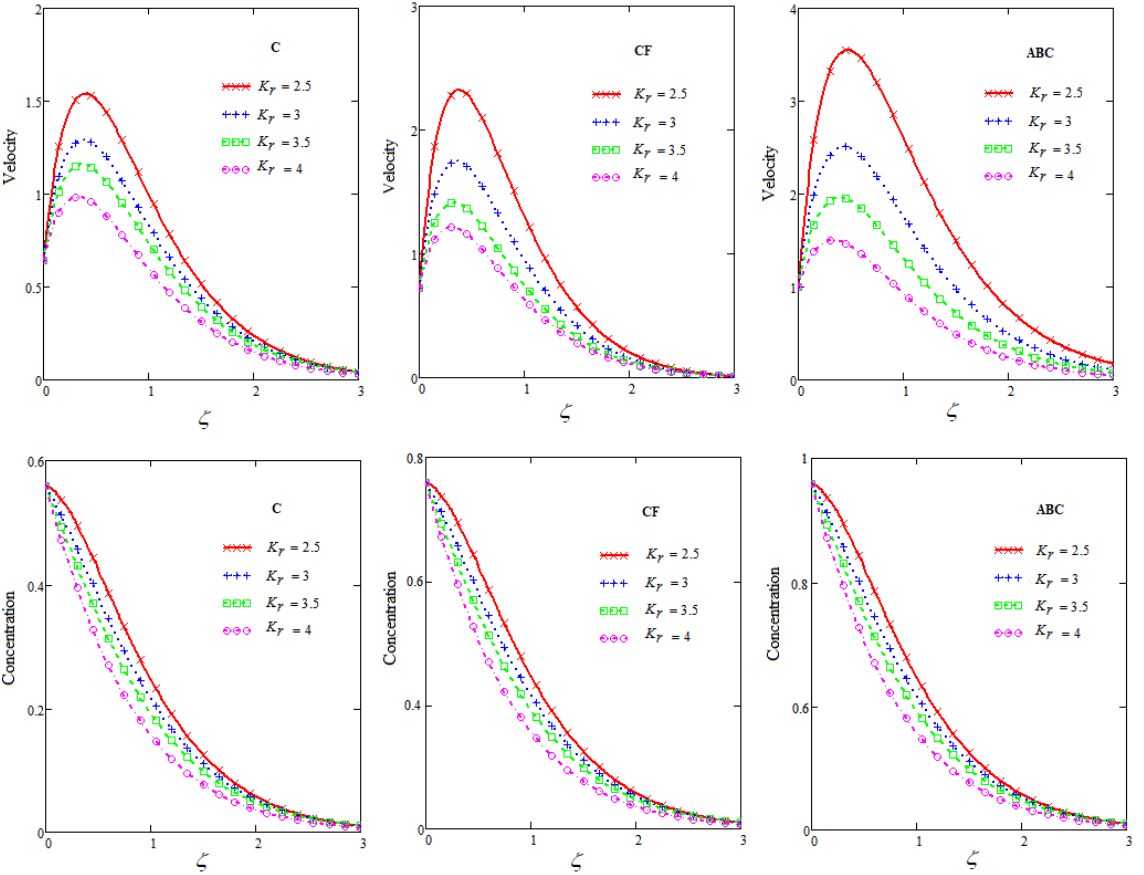
Figure 7. Velocity and concentration curves corresponding to C, CF and ABC with variable K r where P r = 7, S c = 0.66, κ = 0.5, G m = 5, H = 3, R = 5, S r = 3, κ = 0.5, M = 0.5, γ 1 = 0.1, h = 0.5, c = 1.05 and b =